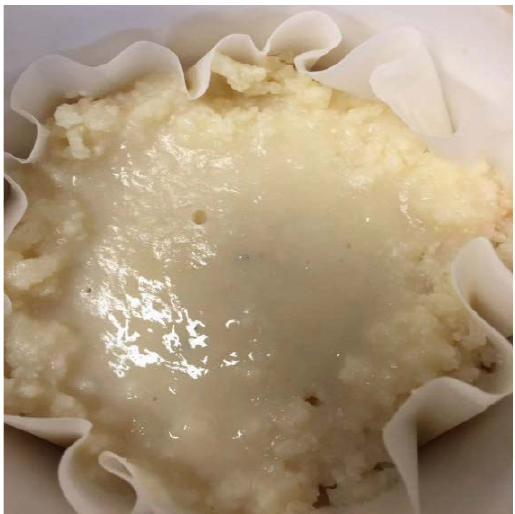
Figure 5. The precipitate in a difficult state of filtration at pH 4.0 after adding Na 2 CO 3.